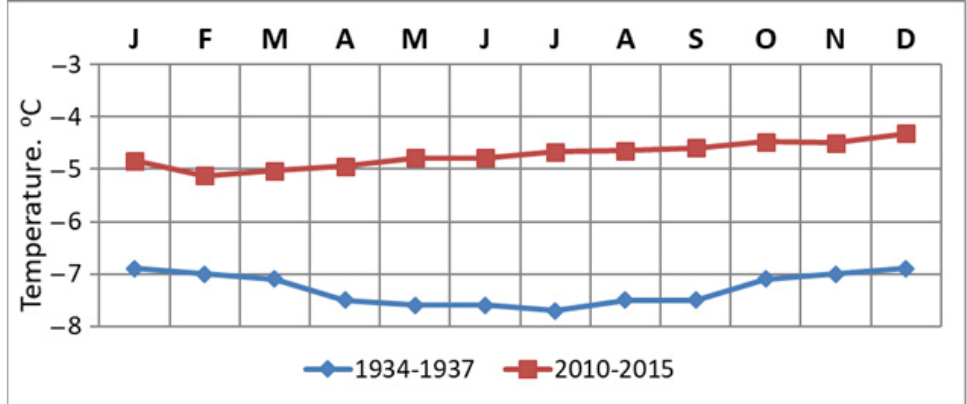
Figure 5. Past (1934–1937) and recent (2010–2015) permafrost temperature graphs for 10 m depth in an urbanised permafrost landscape: 1—based on G.M. Zatsepin and N.M. Zatsepin’s data from Shergin Shaft (compiled based on [23]); 2—based on data from borehole #60.